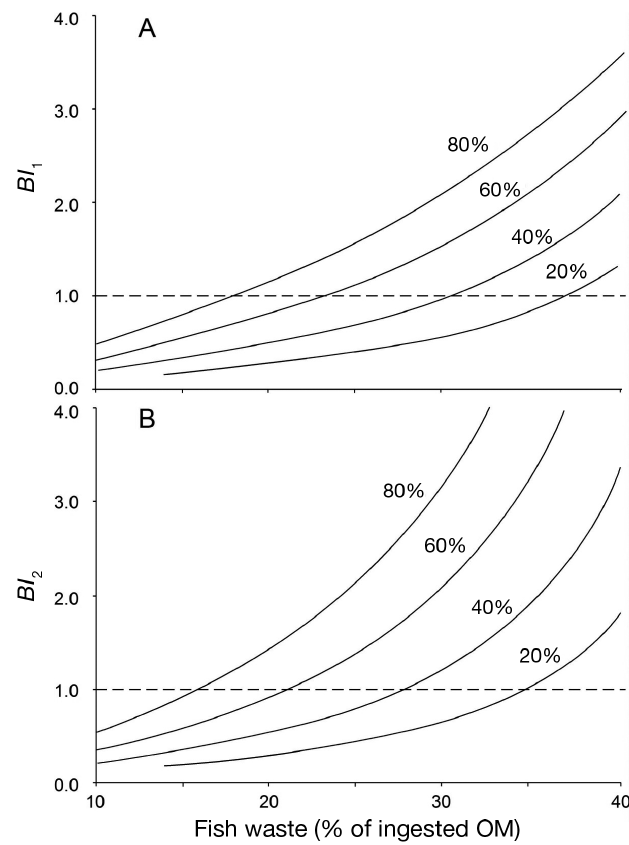
Fig. 3. Relationship between the percentage of fish waste in the mussel diet (ingested organic matter; OM) and the 2 mussel biomitigation indices (see Eqs. 3 & 4 under ‘Biomiti- gation potential’ in the main text). The different lines show results for seston organic content (OC) of 20, 40, 60, and 80%, assuming an OC of fish waste of 77% and